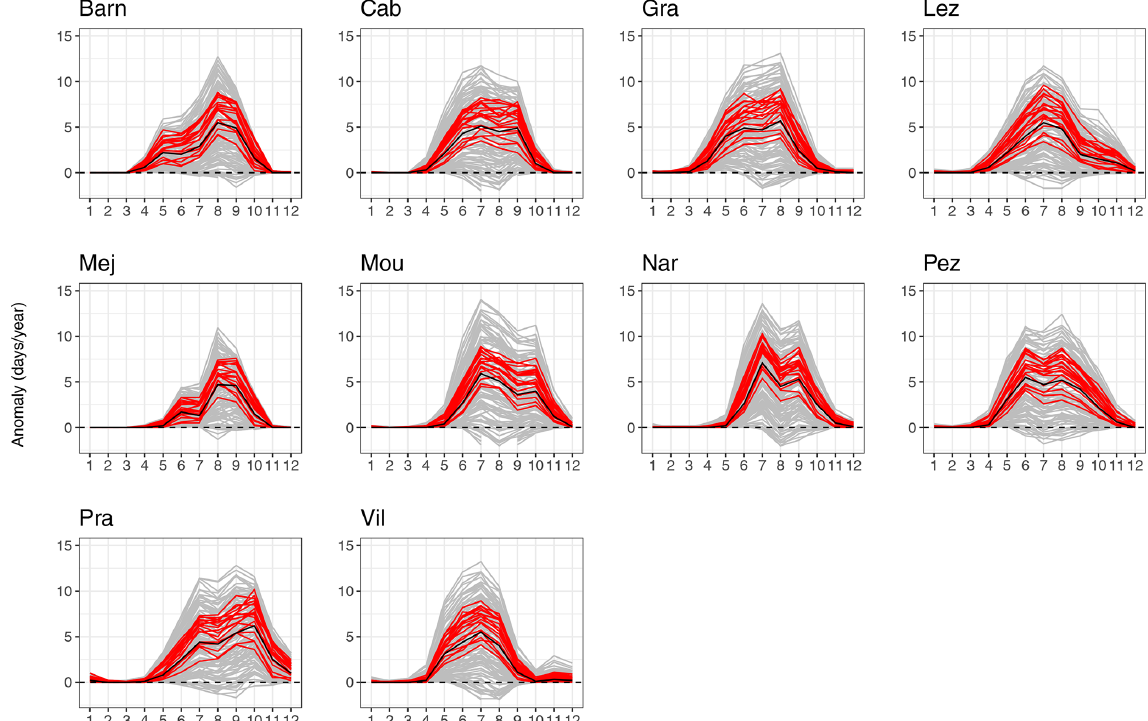
Figure 13. Monthly anomaly of days under extreme drought for a + 4 ◦ C temperature scenario. Gray lines represent the results for all precipitation scenarios with increasing precipitation intensity and intermittence. Black lines represent the median of the scenarios ensem- ble. Red lines represent the change of drought days for the scenarios with a decrease of annual precipitation between − 10% and − 20% (corresponding to scenario RCP8.5, Polade et al.,